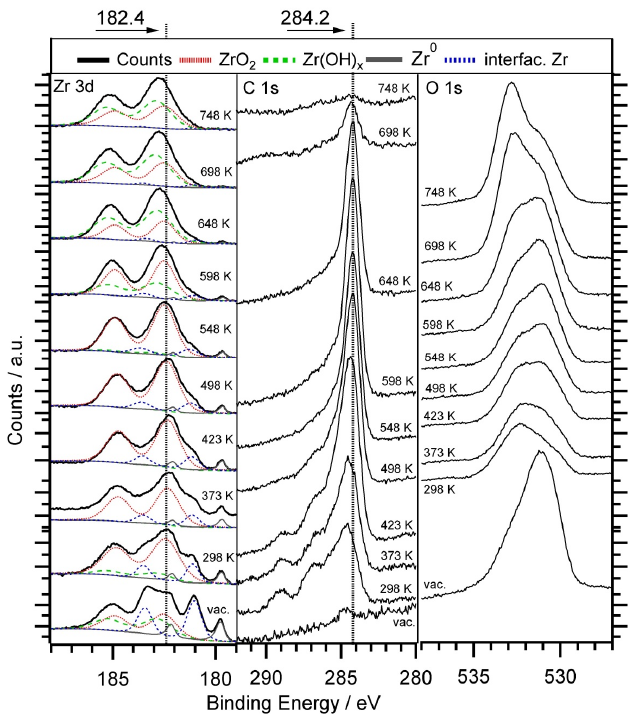
Figure 2. In situ NAP ‐ XPS spectra (Zr 3d, C 1s and O 1s (overlapping with Pd 3p) regions) of 0.5 monolayers (ML) Zr 0 /ZrO x H y , prepared by annealing of CVD grown ZrO x H y (2000 L ZTB at 723 K) in vacuum at 700 K under water ‐ rich MSR conditions (H 2 O:MeOH = 2:1, p total = 0.3 mbar).